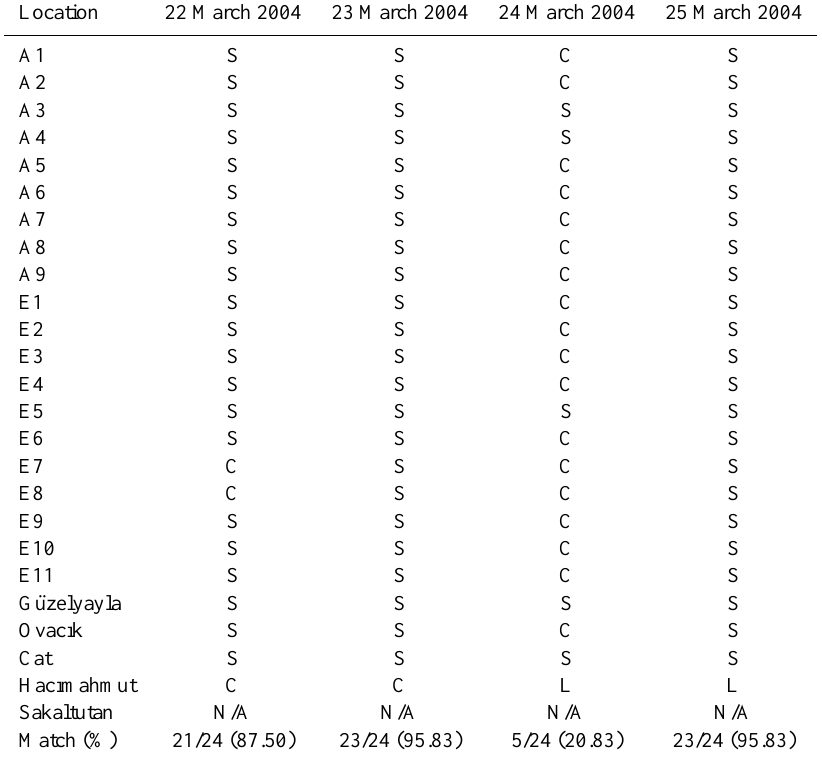
Table 3. Analyses performed for winter 2003–2004 March (ablation period).